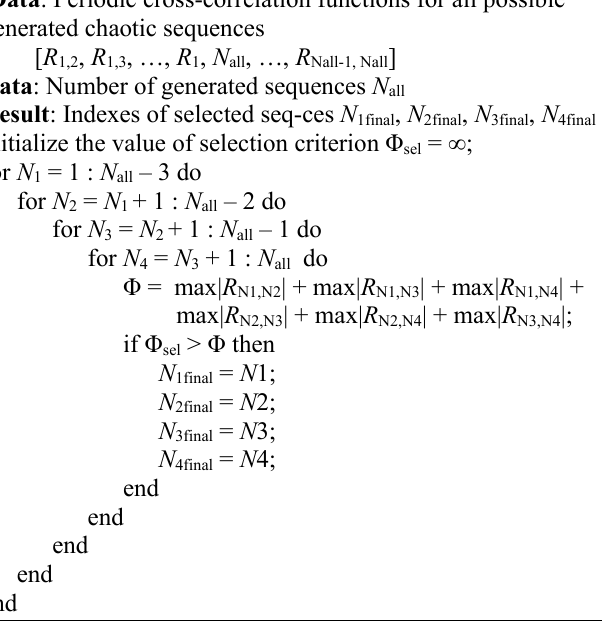
Algorithm 1. Algorithm for the selection of four